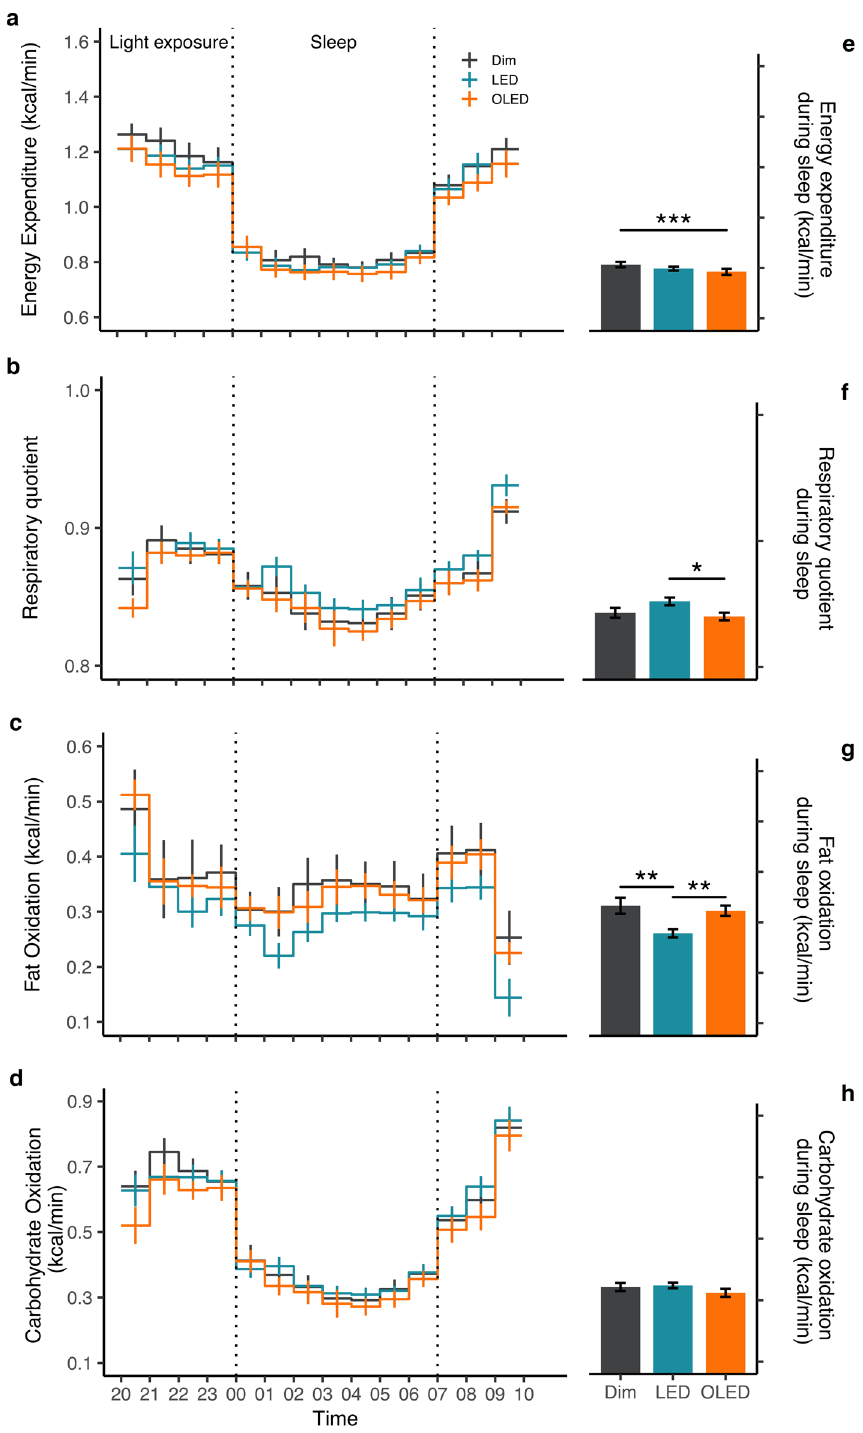
Figure 1. Energy metabolism. Time course (left panel) and mean values during sleep (right panel) are shown for ( a ) energy expenditure, ( b ) respiratory quotient, ( c ) fat oxidation, and ( d ) carbohydrate oxidation indicated as mean ± SE ( n = 10). Significant differences among light conditions in energy metabolism during sleep were assessed by one-way repeated measures ANOVA with Bonferroni’s adjustment, * p < 0.05, ** p < 0.01, *** p <